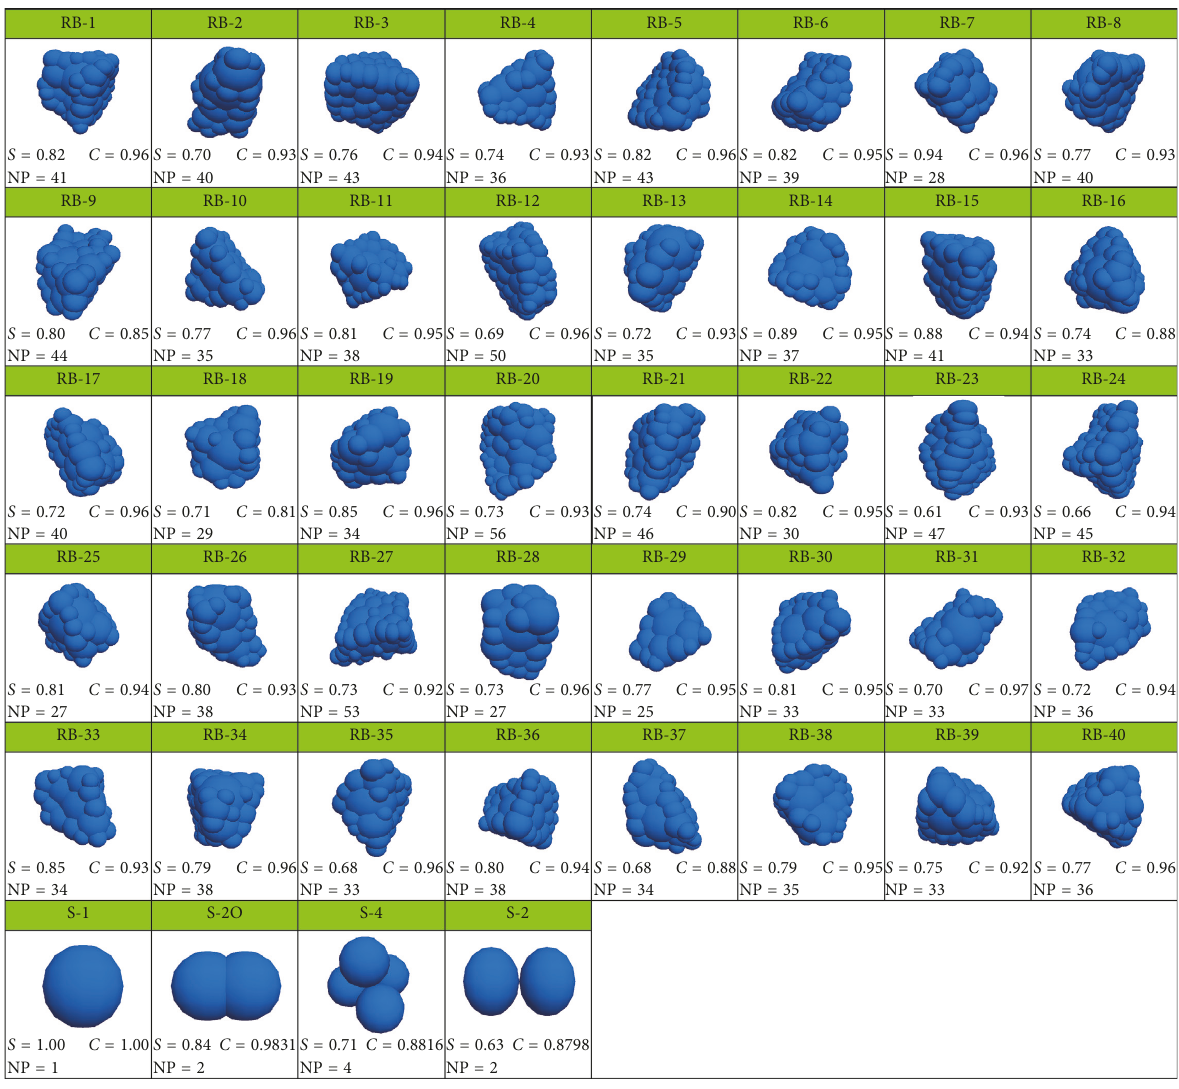
Figure 7: Particle bank (RB-X represents the real ballast clump template with the ID of X , S - X represents the simply created template with the pebble number of X , and S -2O is the 2-ball with overlap clump template) with corresponding sphericity and convexity; S , C , and NP refer to sphericity, convexity, and the number of pebbles,